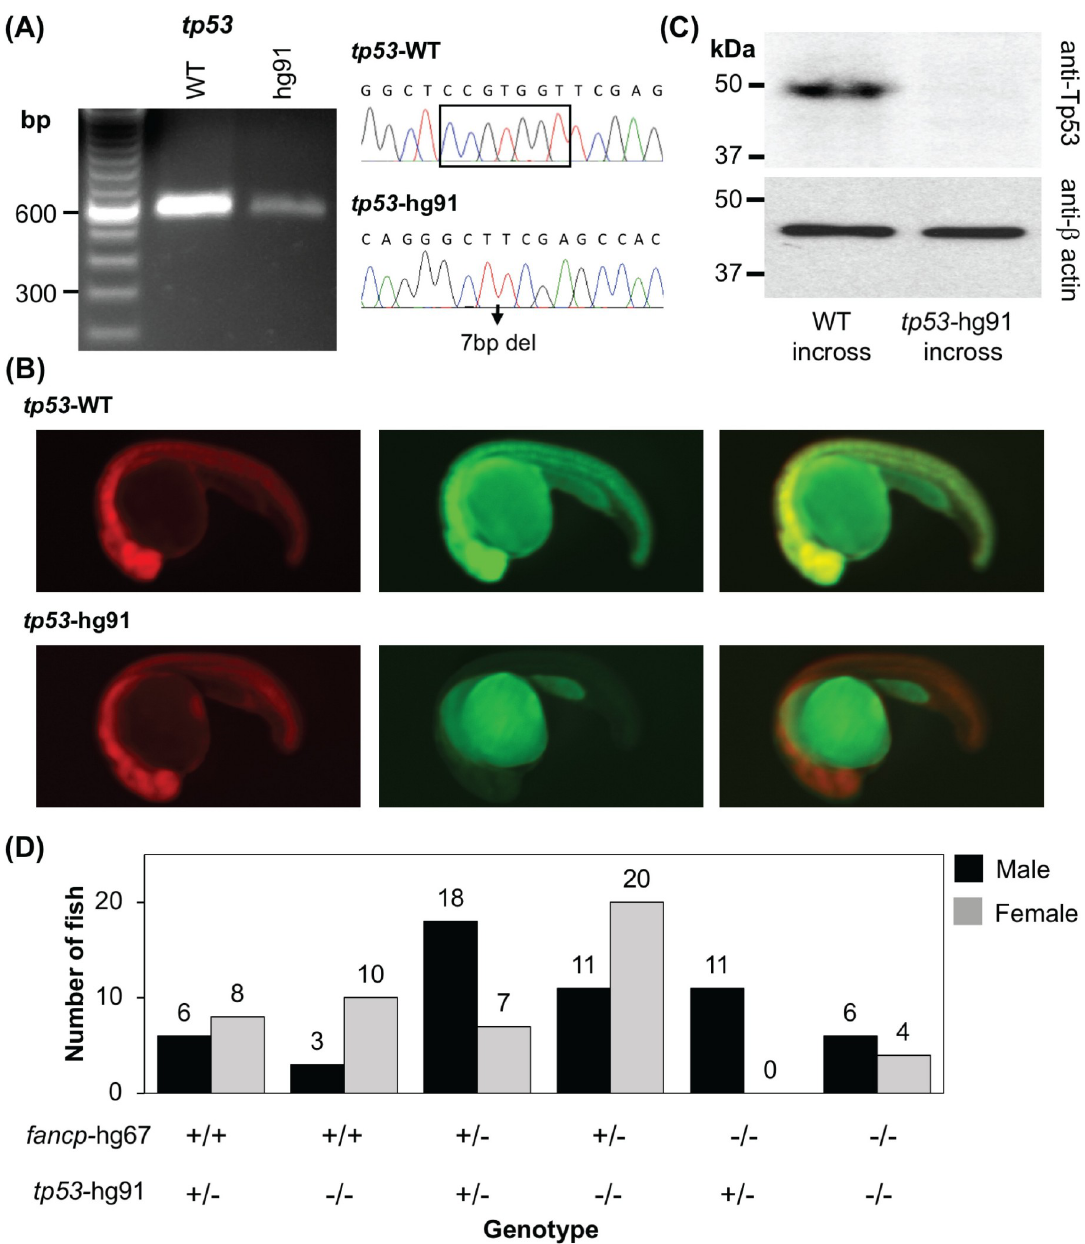
Fig 6. Co-mutation in tp53 gene rescues female-to-male sex reversal of fancp homozygous knockouts. (A) RT-PCR confirmed the absence of any aberrant splice variants around tp53 gene mutation. Sanger sequencing confirmed the presence of CRISPR-Cas9 introduced 7bp deletion mutation. The products were resolved on 2% agarose gel. (B) Reporter assay to check the expression of tp53 frameshift mutant. Representative images at 1 dpf of embryos co-injected with the specified reporter mRNA and TagRFP are shown as RFP (left panel), GFP (middle panel) and merged (right panel). (C) Western blot analysis shows absence of Tp53 protein in the knockout embryo extracts. Twenty-four hpf embryos collected from tp53 hg91/hg91 homozygous knockout fish incross were used to check the loss of expression of Tp53 protein. Embryos obtained from TAB5 incross were used as WT controls. Expression of β -actin was used as loading control. (D) Progenies from fancp hg67/+ ; tp53 hg91/+ and fancp hg67/+ ; tp53 hg91/hg91 breeding were genotyped around 4 mpf and the sex was determined. Number of male and female fish in each genotype category is presented. The genotypes are marked on the X-axis. Among the fancp homozygous knockouts, only males were observed with fancp hg67/hg67 ; tp53 hg91/+ genotype, whereas both males and females were observed with fancp hg67/hg67 ; tp53 hg91/hg91 genotype.